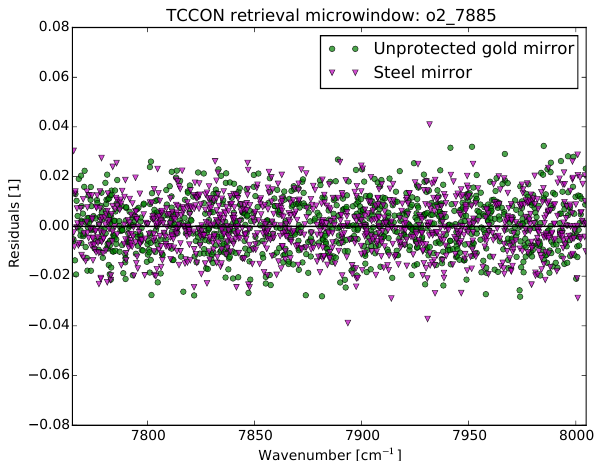
Figure 15. Spectral residuals in the O 2 retrieval microwindow around 7885cm − 1 that were derived from spectra S 1 (gold mir- ror) and S 4 (steel mirror) in Table 3. This microwindow was chosen because it covers the widest spectral range in the standard TCCON retrieval. Nonlinearities in the stainless steel mirrors’ frequency re- sponse should have the largest effect in this microwindow. For bet- ter visibility, only a subset of 1000 randomly chosen data points (instead of more than 30000) was plotted for each mirror type.